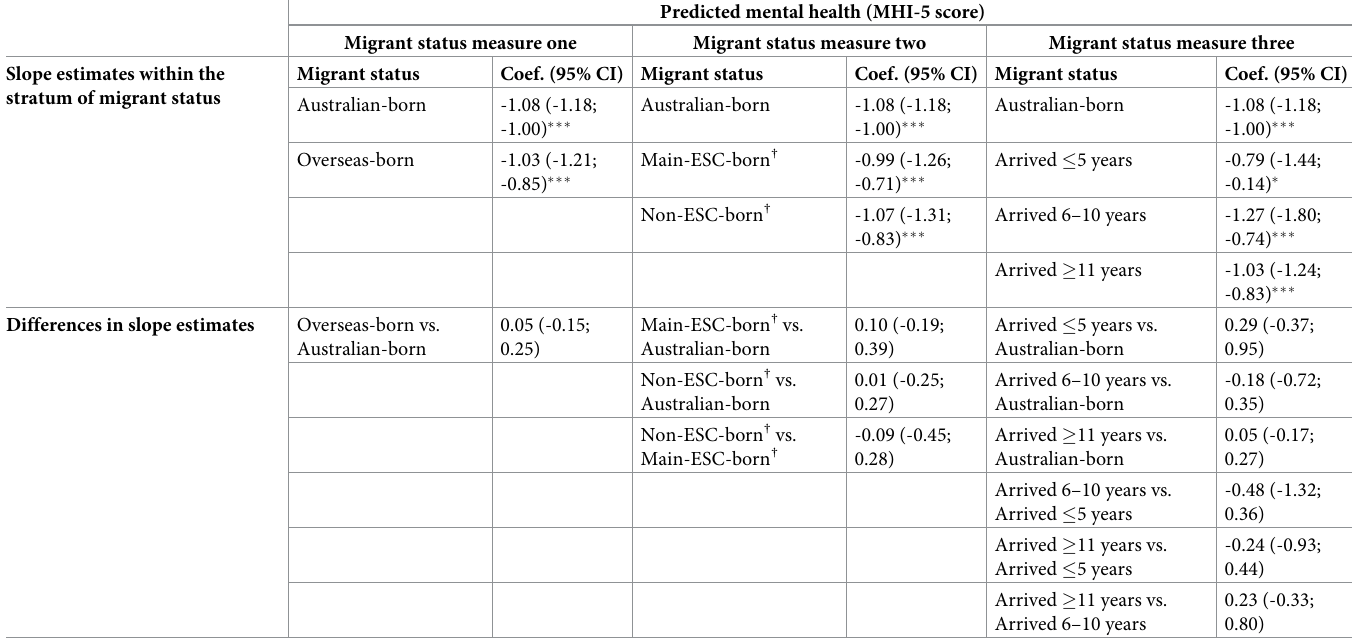
Table 5. Relationships between job insecurity and mental health stratified by three measures of migrant status: The slope estimate within each stratum of migrant status and the differences in the slope estimates between groups, controlled for gender, age and educational